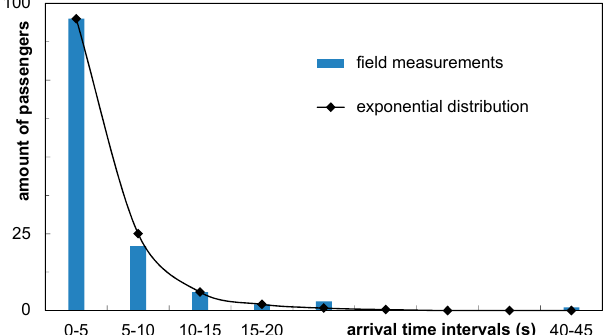
Figure 8. Inter-arrival times clustered in 5 s intervals and exponential distributed values.